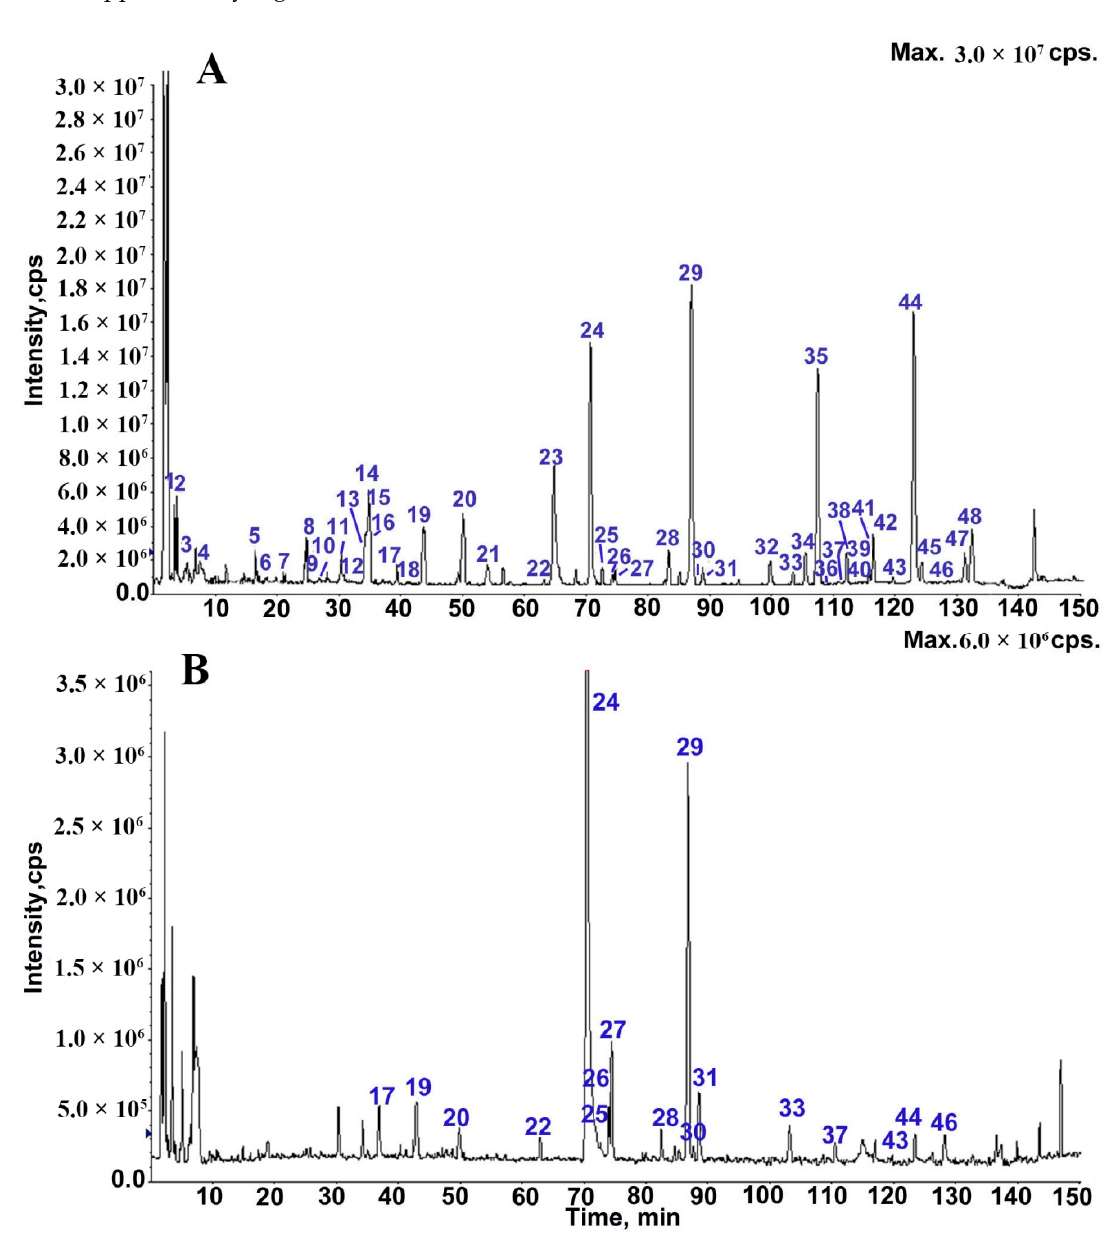
Figure 1. The TICs of WLY by LC-MS in the positive ( A ) and negative ( B ) modes.